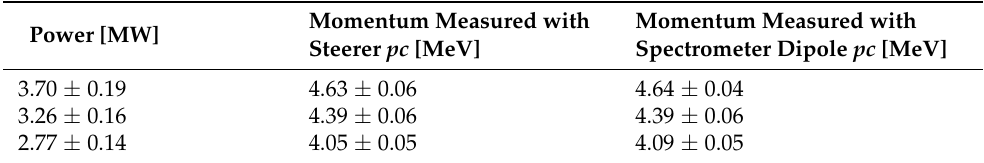
Table 2. Comparison of the momentum measurement results for different RF powers using two different measurement techniques (spectrometer dipole and steerer magnets). Power